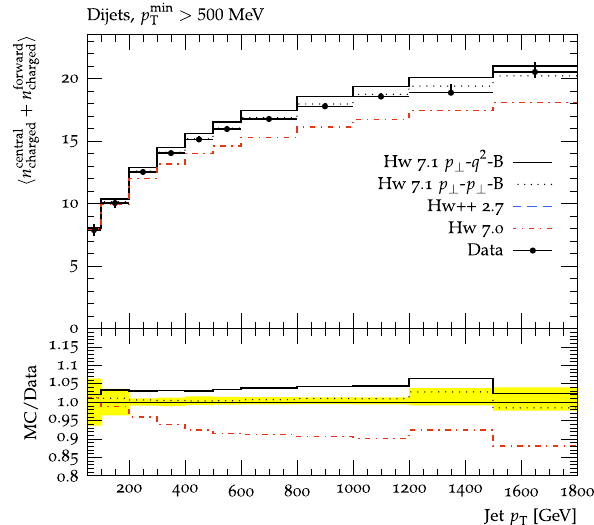
Fig. 12 The average number of charged particles in jets as a function of the jet transverse momentum compared with data from the ATLAS